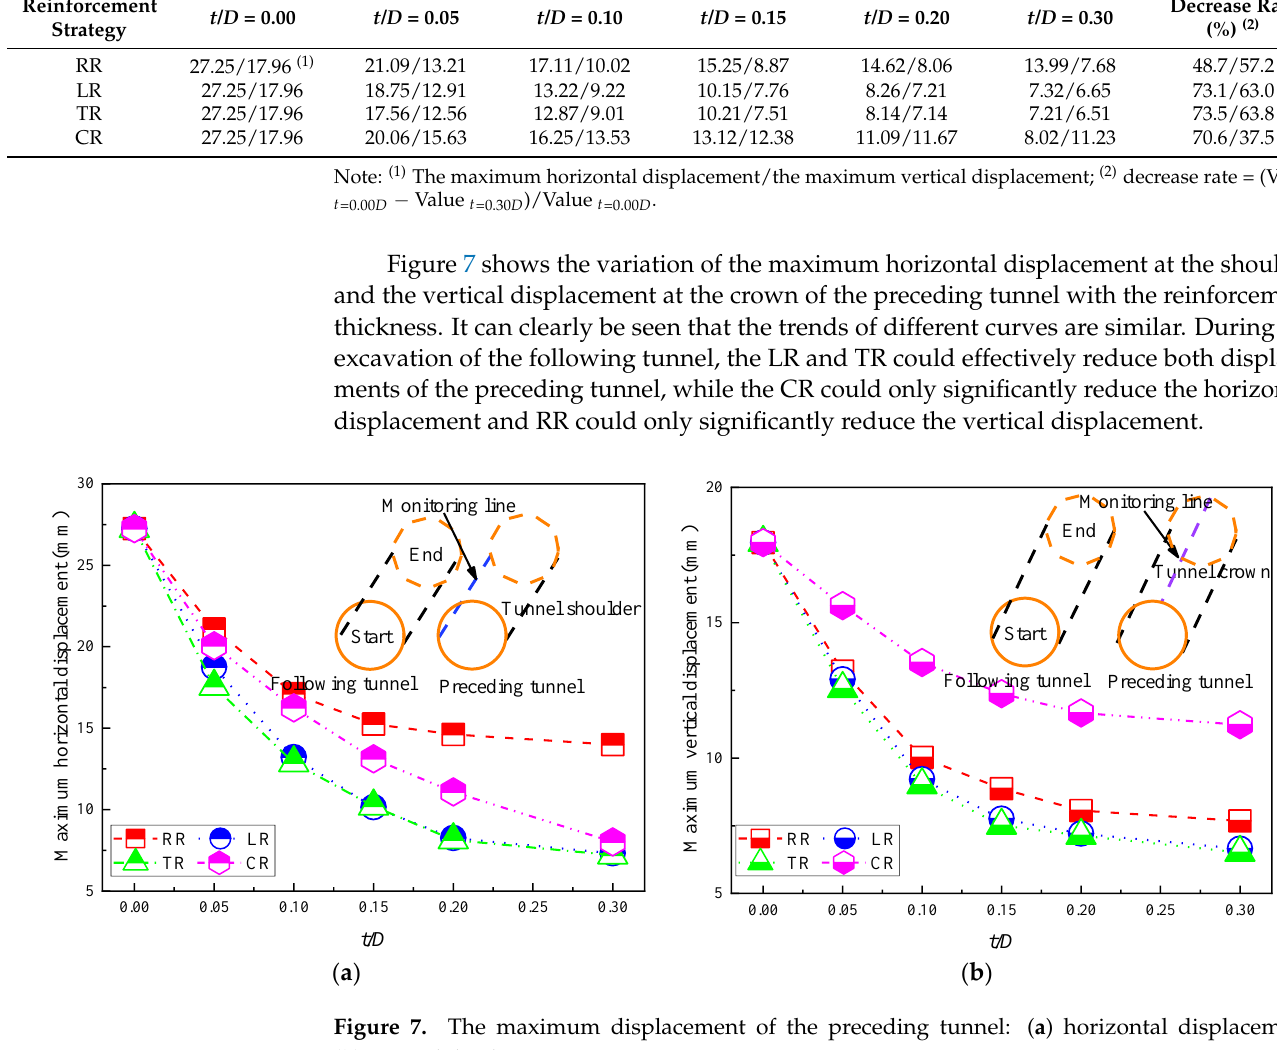
Table 2. The maximum value of horizontal and vertical displacements (in mm).